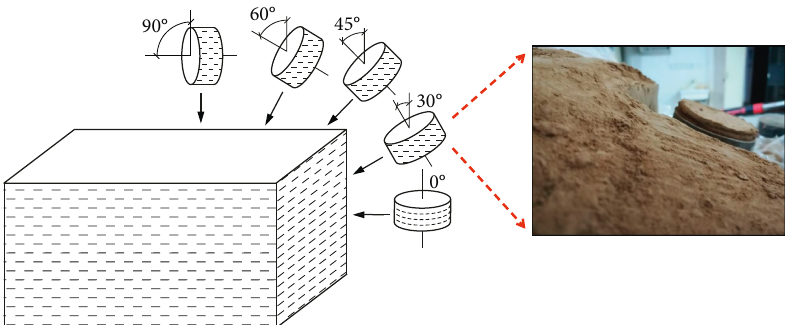
Figure 5: Direct shear test on the loess soil with different sampling